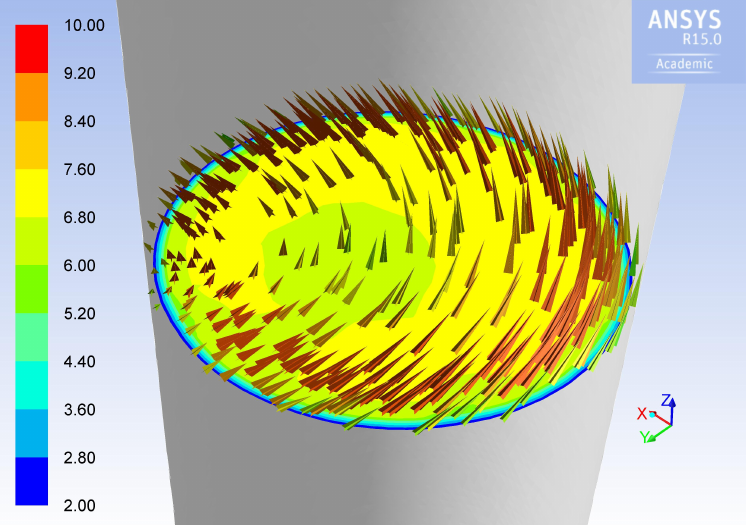
Figure 14. Simulation of the flow field along a horizontal section of the duct, corresponding to the Pitot port position. Units are